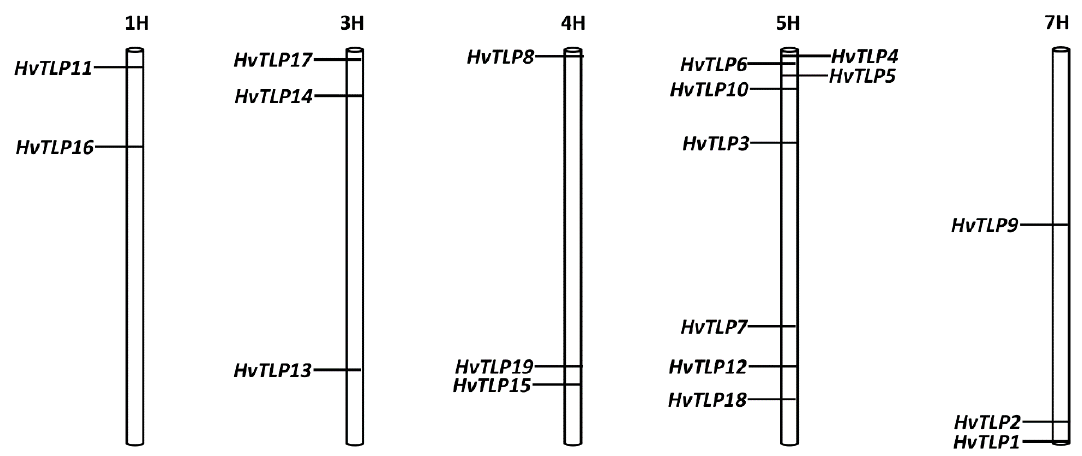
Figure 6. Map locations of HvTLP genes in barley genomes. Exact positions are shown in Table